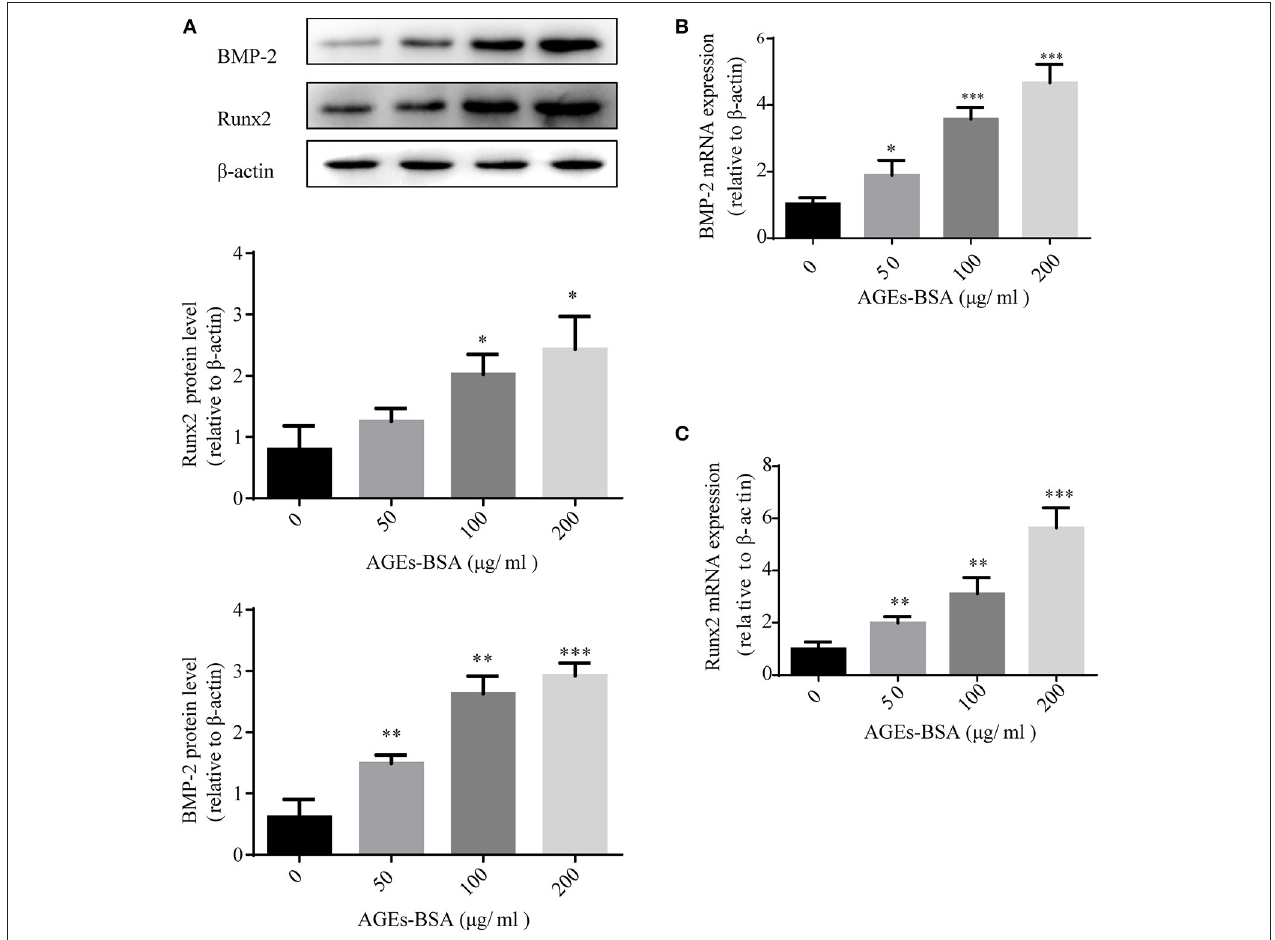
FIGURE 2 | AGEs-BSA upregulates BMP-2 and Runx2 expression in VSMCs. BMP-2 and Runx2 mRNA and protein levels in VSMCs treated with 200 µ g/mL BSA(Control group) or 50–200 µ g/mL AGEs-BSA for 48h. Results are means ± SD. * p < 0.05, ** p < 0.01, and *** p < 0.001 vs. the Control group.